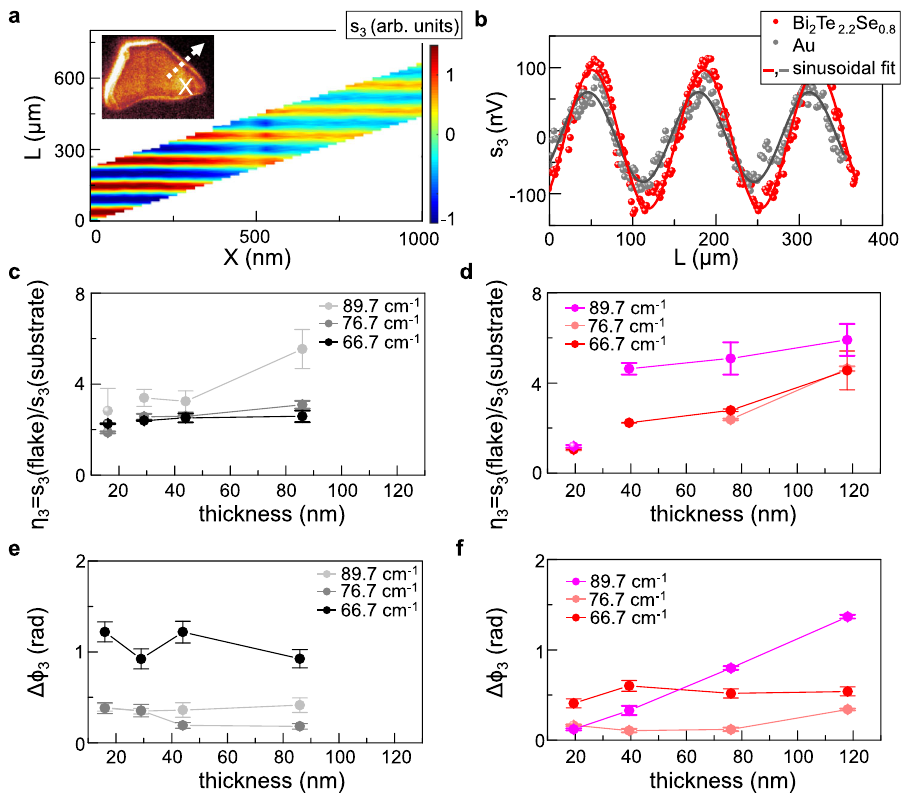
Fig. 3 Amplitude and phase contrasts. a SM maps of s 3 signal on fl ake A2 of Bi 2 Se 3 as a function of the cavity length L and of the position X moving on the line orthogonal to the fl ake edge sketched in the inset by the white dashed arrow; the L sampling interval changes with X due to the delay line backlash. b SM fringes of s 3 as a function of the cavity length L at a fi xed position X on fl ake B3 of Bi 2 Te 2.2 Se 0.8 (red dots) and on the substrate (gray dots) acquired at 76.7cm − 1 together with the sinusoidal best fi t (solid lines). c , d Signal contrast η 3 evaluated dividing the signal amplitude s 3 on Bi 2 Se 3 ( c ) and on Bi 2 Te 2.2 Se 0.8 ( d ) by that collected on the substrate, all extracted from the sinusoidal fi t of the SM fringes acquired on 1- μ m-length X line scan across the fl ake/substrate interface, measured at three different probing frequencies. Error bars indicate 95% con fi dence bands from the fi t. e , f Phase variation 4 ϕ from the substrate to the fl akes, extracted from the sinusoidal fi t of the SM fringes acquired on 1- μ m-length X line scan across the fl ake/substrate interface, as a function of the fl ake thickness at the three different frequencies for Bi 2 Se 3 ( e ) and Bi 2 Te 2.2 Se 0.8 ( f ). Error bars indicate 95% con fi dence bands from the fi